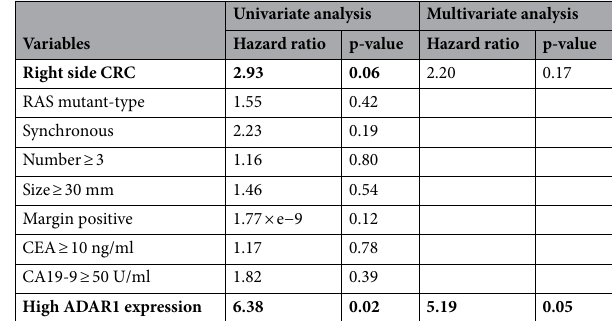
Univariate analysis Multivariate analysis Variables Hazard ratio p-value Hazard ratio